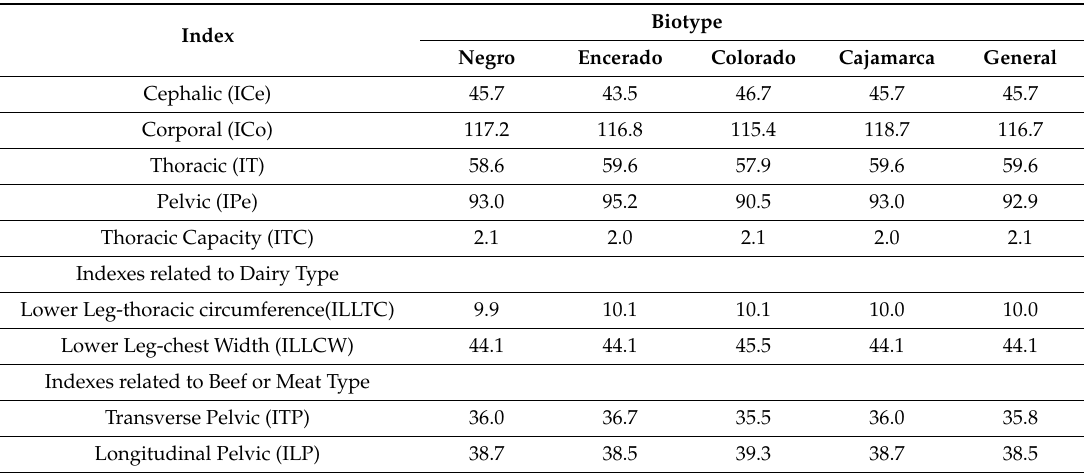
Table 4. Zoometric indexes from Criollo Lojano